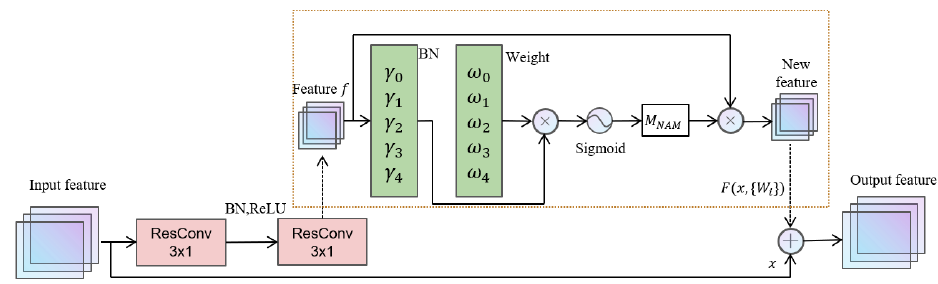
Figure 2. Basicblock-NAM